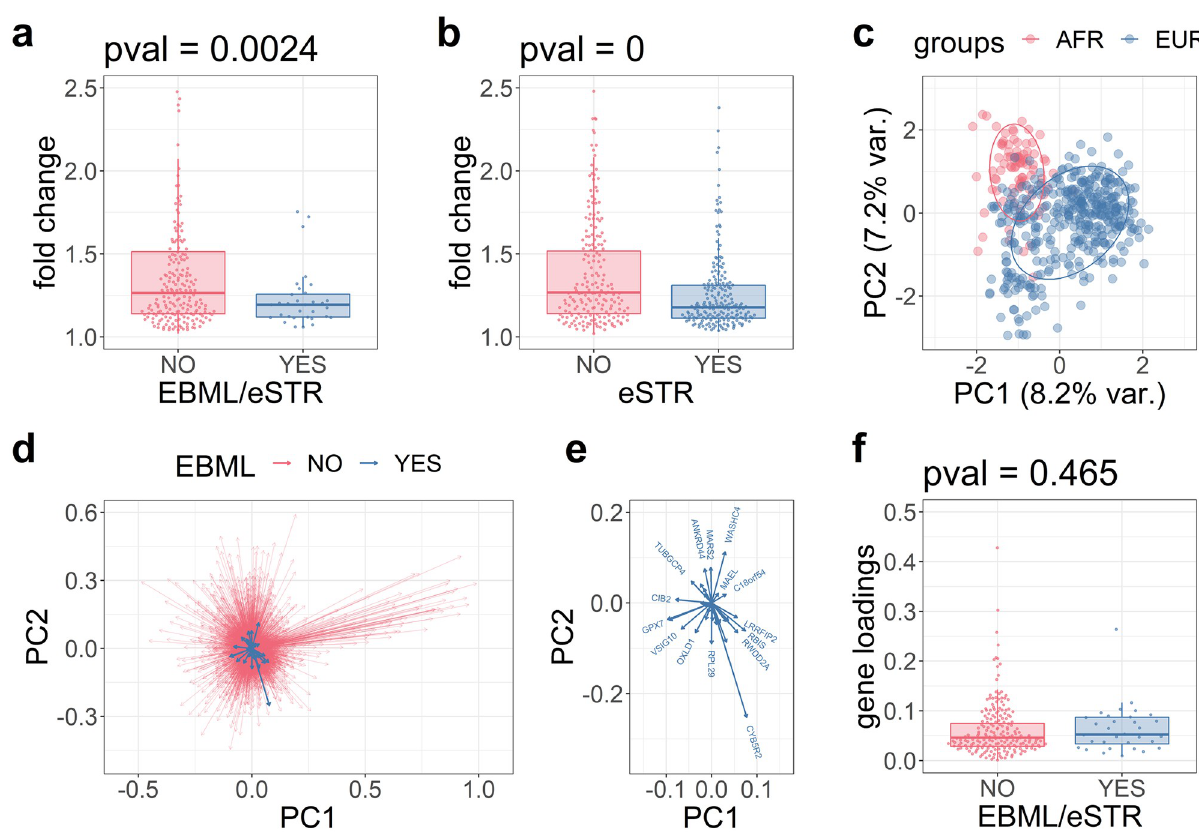
Fig 3. The contribution of overlapping EBML/eSTRs to differential gene expression. a , fold change for differentially expressed genes associated with EBML/eSTRs (blue) compared to all other genes (red). The difference is statistically significant (p = .0024; two sided Kolmogorov-Smirnov test). b , fold change for differentially expressed genes associated with eSTRs (blue) compared to all other genes (red). The difference is statistically significant (p = 0; two sided Kolmogorov-Smirnov test). c , PCA plot of differentially expressed genes reveals two population clusters: African samples (red) and European samples (blue). d , PCA loadings for differentially expressed genes including those associated with EBML/eSTRs (blue) and all other genes (red). e , inset of PCA loadings for genes associated with EBML/eSTRs. f , a comparison of PCA loadings finds no significant difference for genes association with EBML/eSTRs vs all other genes (p = .465; two sided Kolmogorov-Smirnov test).